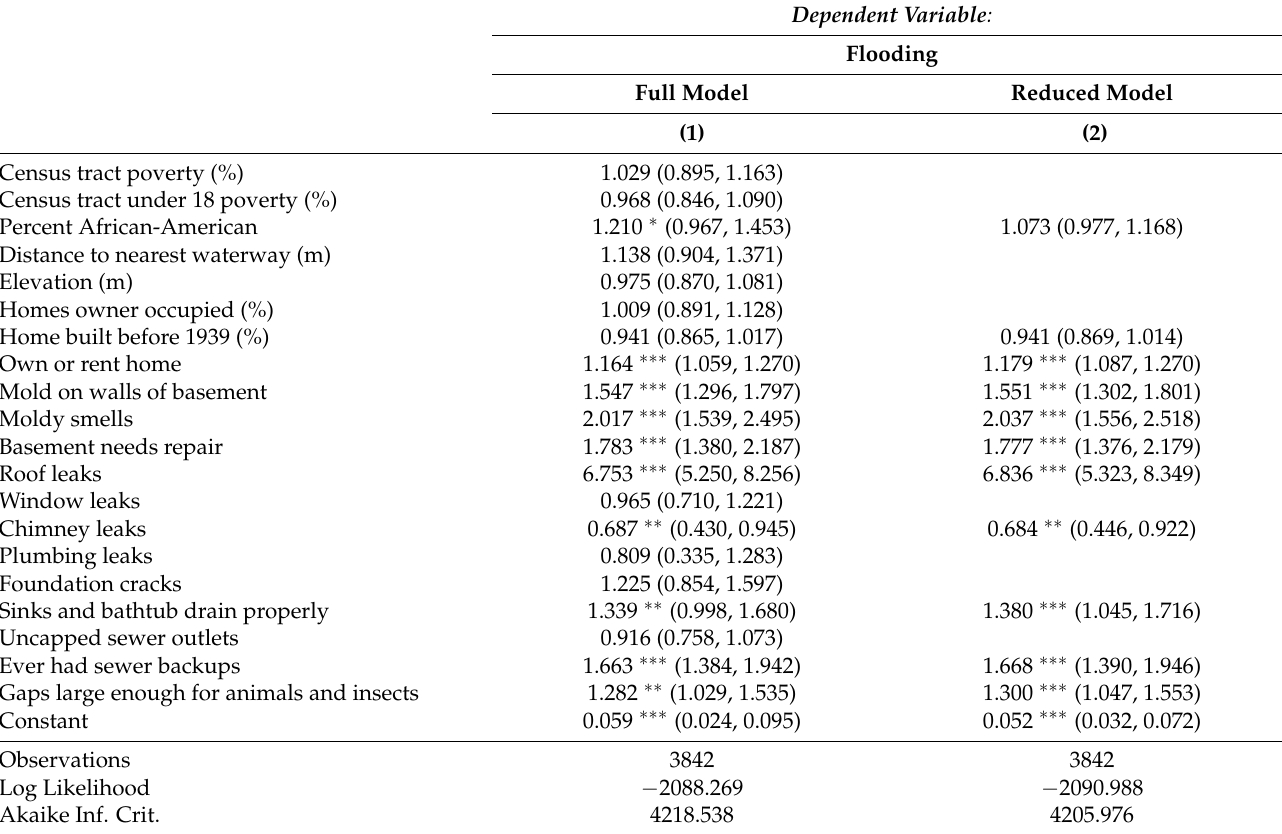
Table 4. Full and reduced models of flooding using all sufficiently represented variables. Reduced model found through backwards selection through AIC. All continuous variables have been standardized and thus odds ratios for these variables represent changes in odds given unit changes in